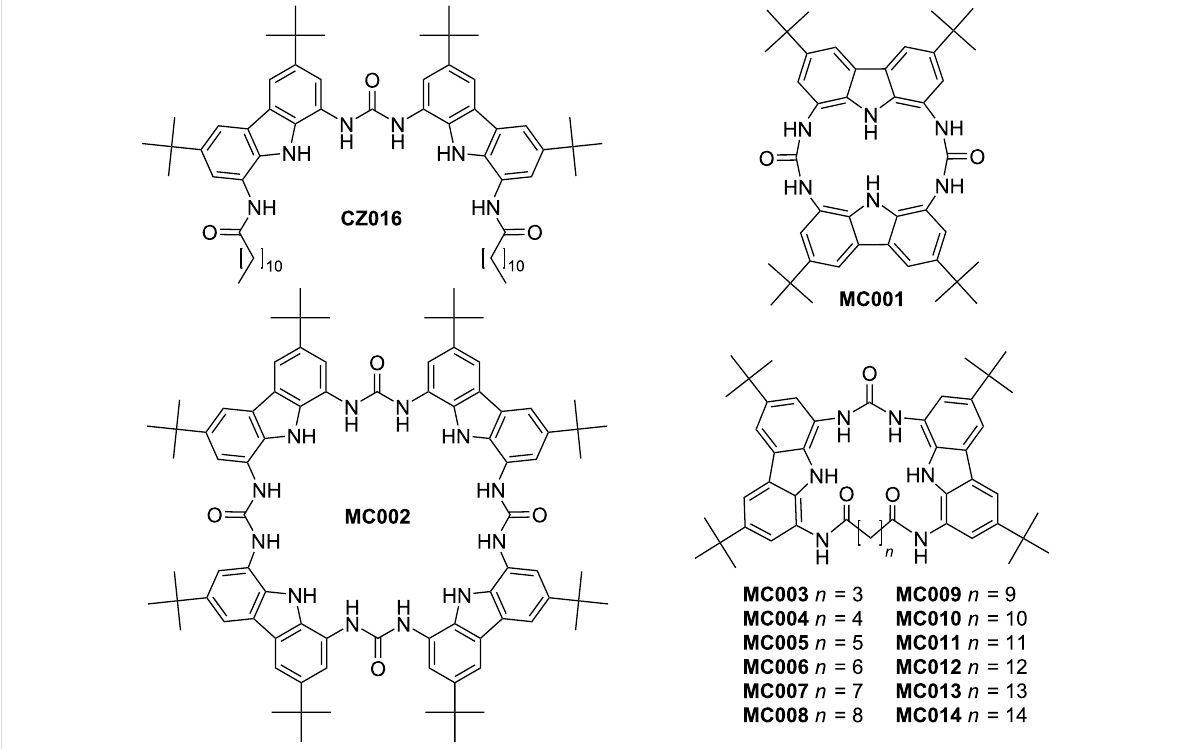
Figure 3: Studied receptor